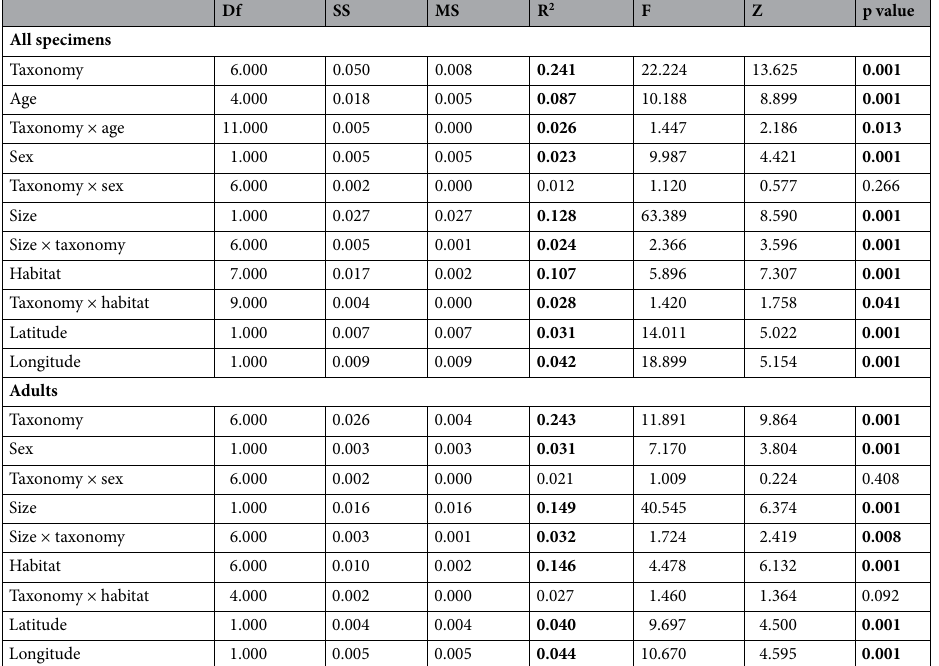
Table 1. Multivariate regressions on skull shape for all specimens and adults only. Significant values are in bold.